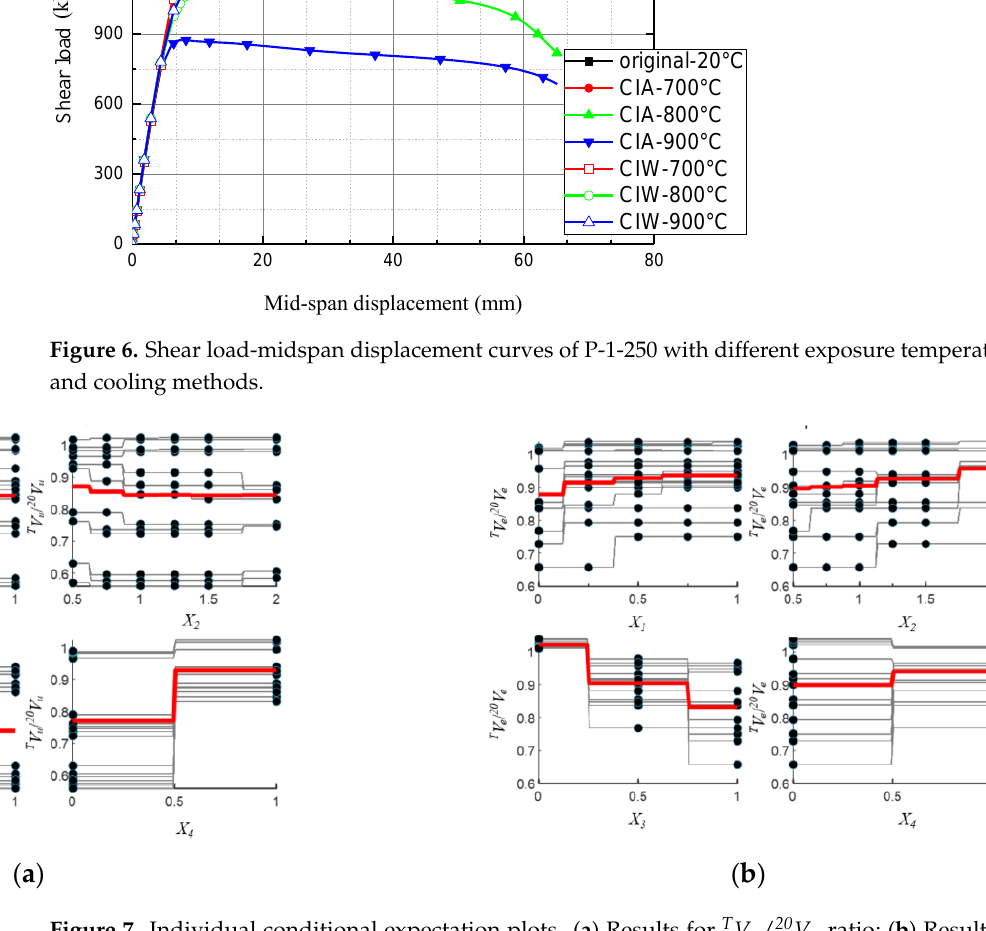
Figure 7. Individual conditional expectation plots. ( a ) Results for T V u / 20 V u ratio; ( b ) Results for T V e / 20 V e ratio.